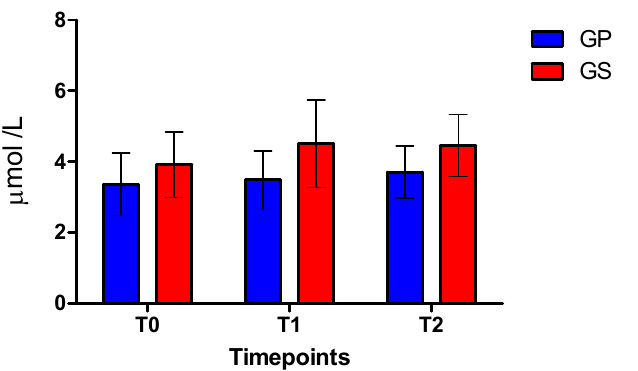
FIGURE 5 - Serum lactate levels (micromoles per liter) in children anesthetized with Propofol (GP) or Sevoflurane (GS). Bars represent mean±SD of GP (blue bars) and GS (red bars) groups at T0, after radial artery cannulation, T1, 30 minutes after cardiopulmonary bypass launch and T2, at the end of the surgical procedure. Values in T0, T1 and T2 timepoints are not significantly different in each group by Friedman´s test. GS is not different from GP group by Wilcoxon test.